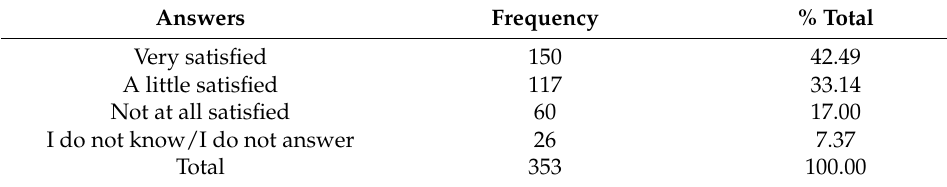
Table 6. Results for the attitudes of believers for the reopening of